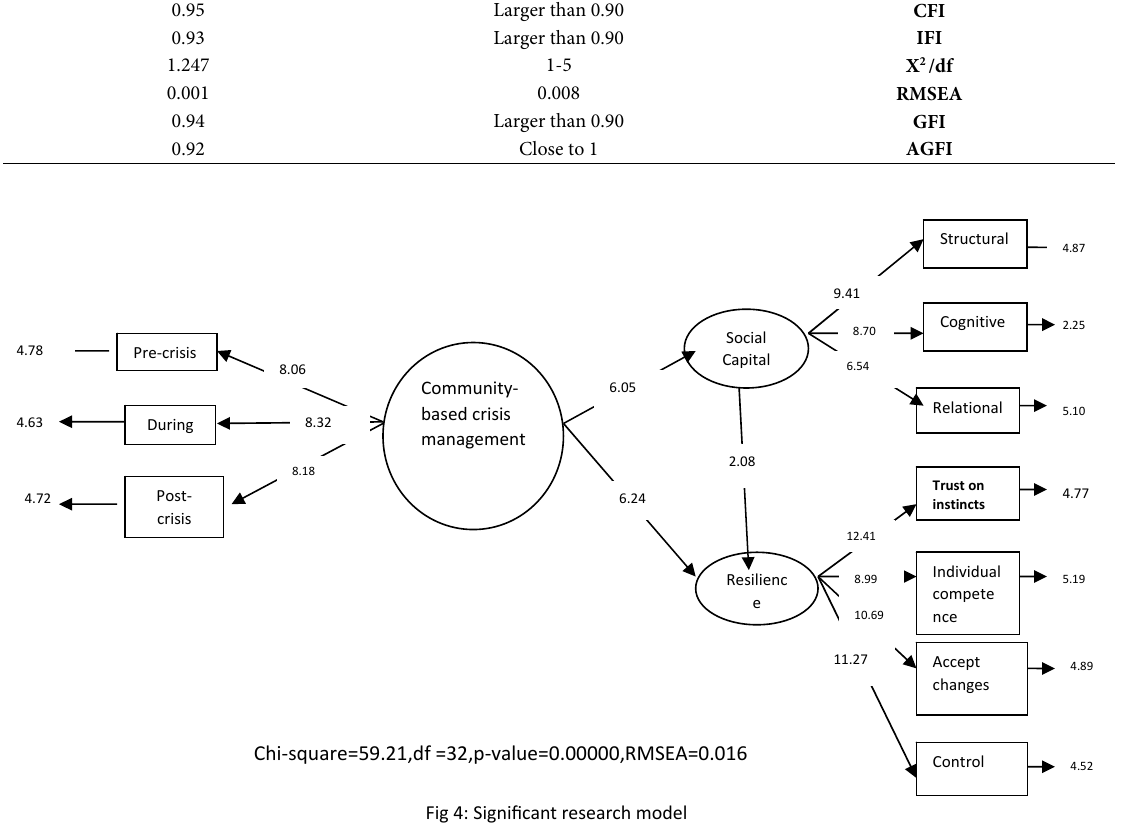
Fig 4: Significant research model